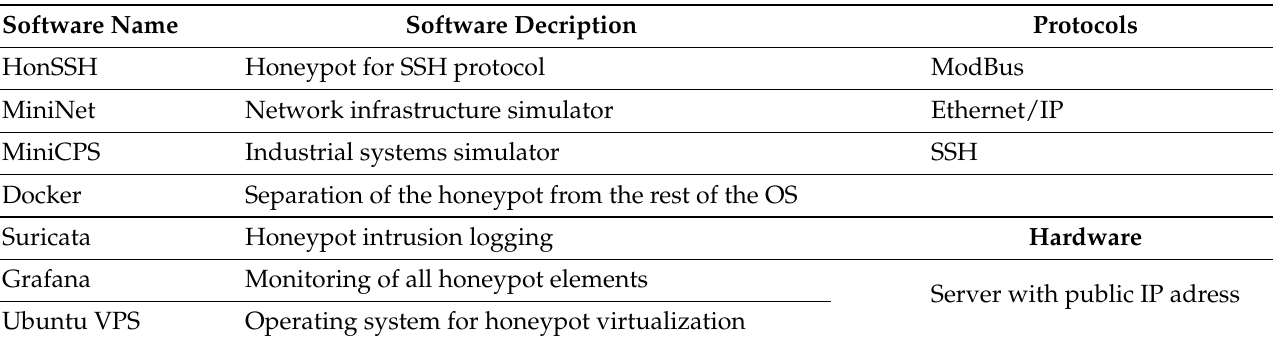
Table 6. Components of honeypot